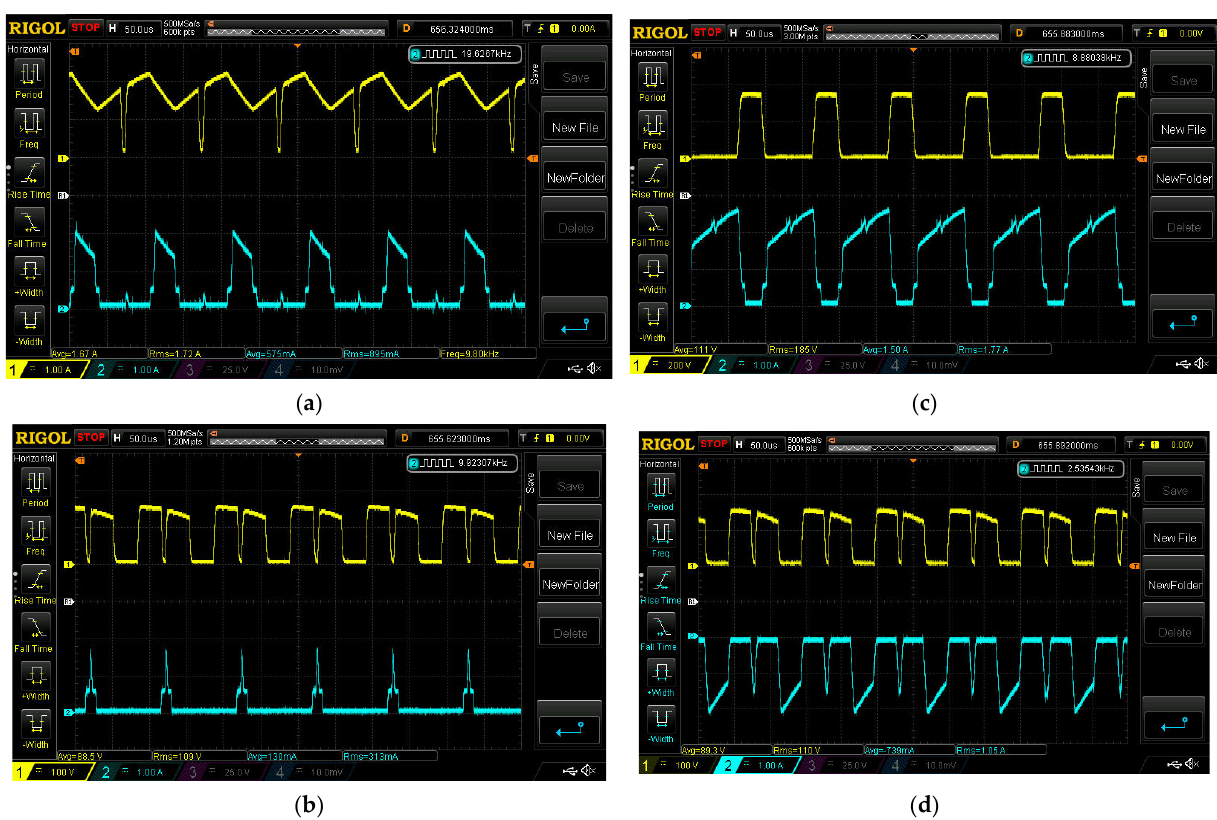
Figure 10. Experimental Wave Form of Switch and Diode in ESS Charging Domain.